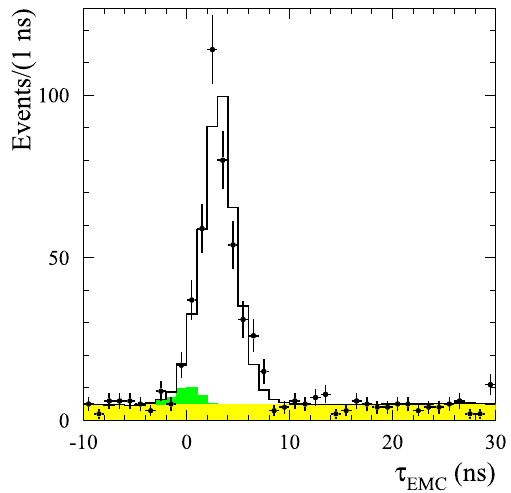
Fig. 4 The τ EMC distribution for selected data events collected in 2019 (points with error bars) at E b = 945 MeV (left panel) and at E b = 973 MeV (right panel). The solid histogram is the result of the